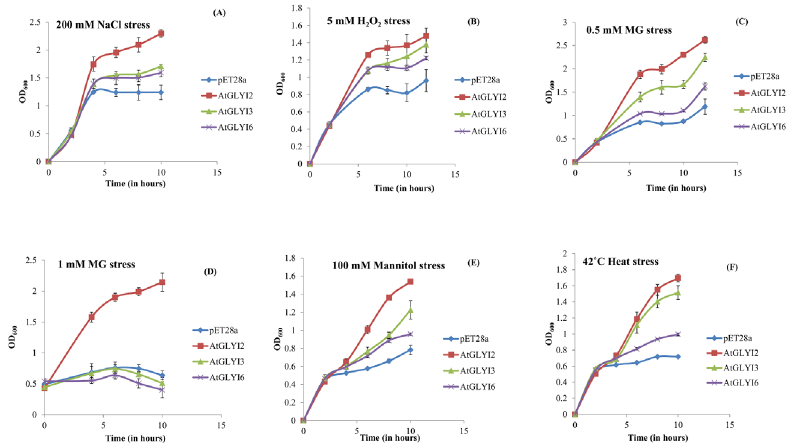
Fig 4. Stress tolerance assay of E . coli expressing AtGLYI genes. The E . coli cells transformed with AtGLYI2 (shown in red color), AtGLYI3 (shown in green color) and AtGLYI6 (shown in purple color)